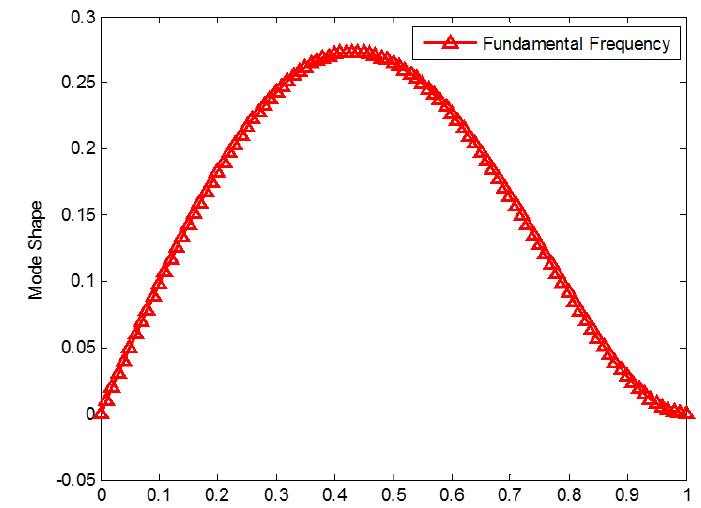
Figure 4. Fundamental mode shape of simply supported with clamped edge condition